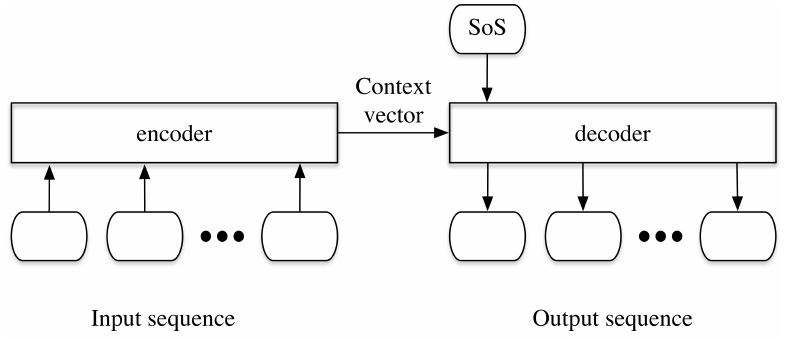
Figure 3. The encoder-decoder structure of the seq2seq